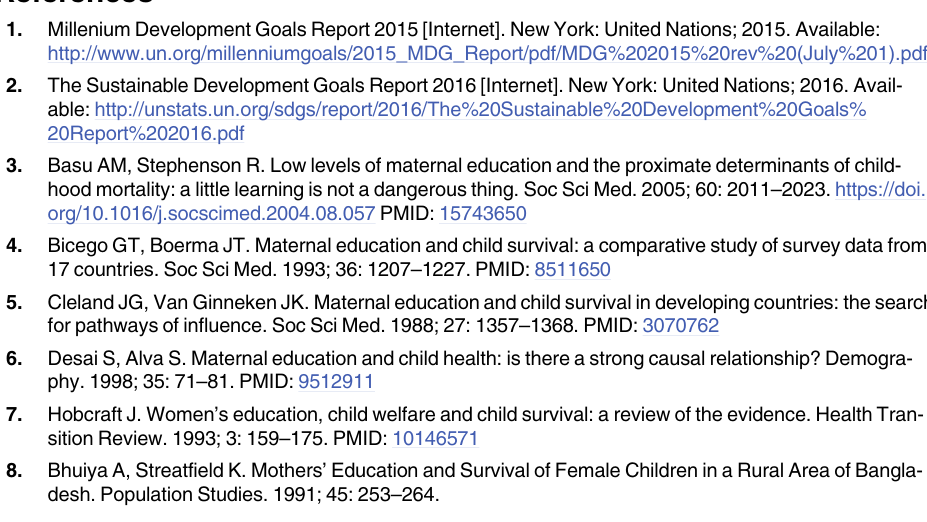
S2 Table. Predictive validity by true mean. Exact values of data shown in Fig 2. Predictive validity metrics for the mean and standard deviation of attainment by one-year increments of true mean attainment in the population. Space-time distance model results shown using hyper-parameter set with optimal RMSE in mean attainment. S3 Table. Predictive validity of weighted regression space-time distance